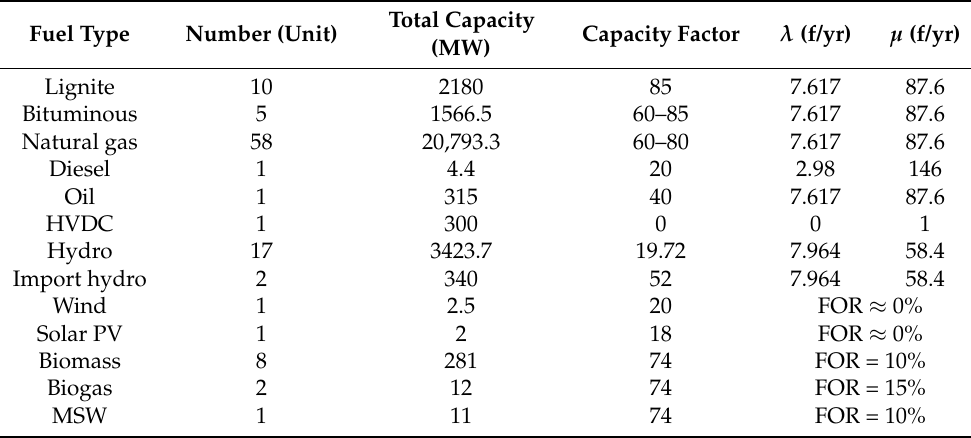
Table A1. Generation system including the installed capacity of each plant and reliability